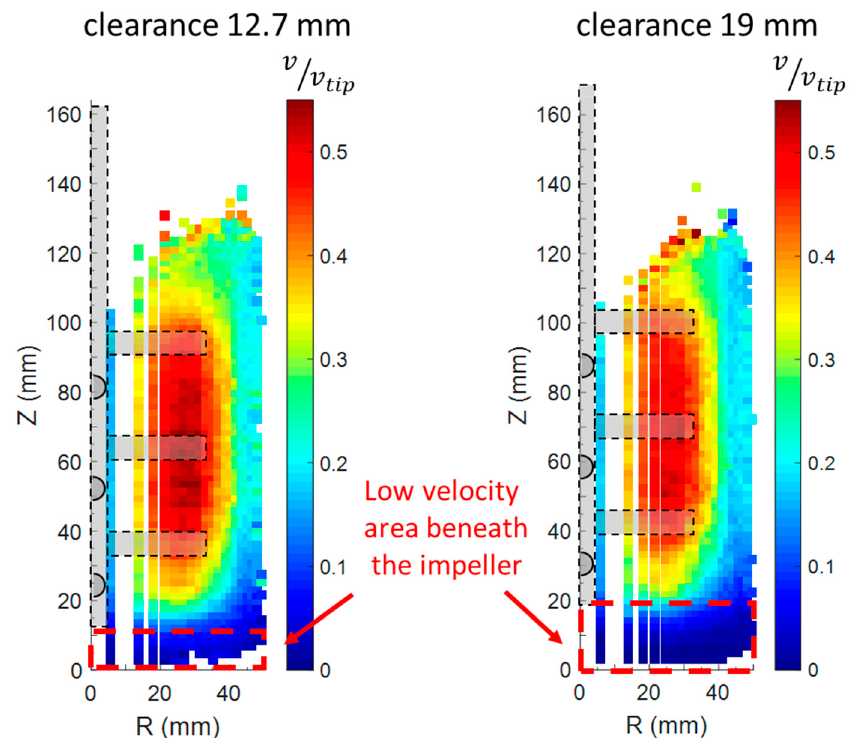
Figure 7. PEPT dimensionless velocity magnitude ( v / v tip ) for two values of clearance: 12.7 mm and 19 mm. Test case using the bead loading of 2.4 kg and the impeller speed of 300 rpm.